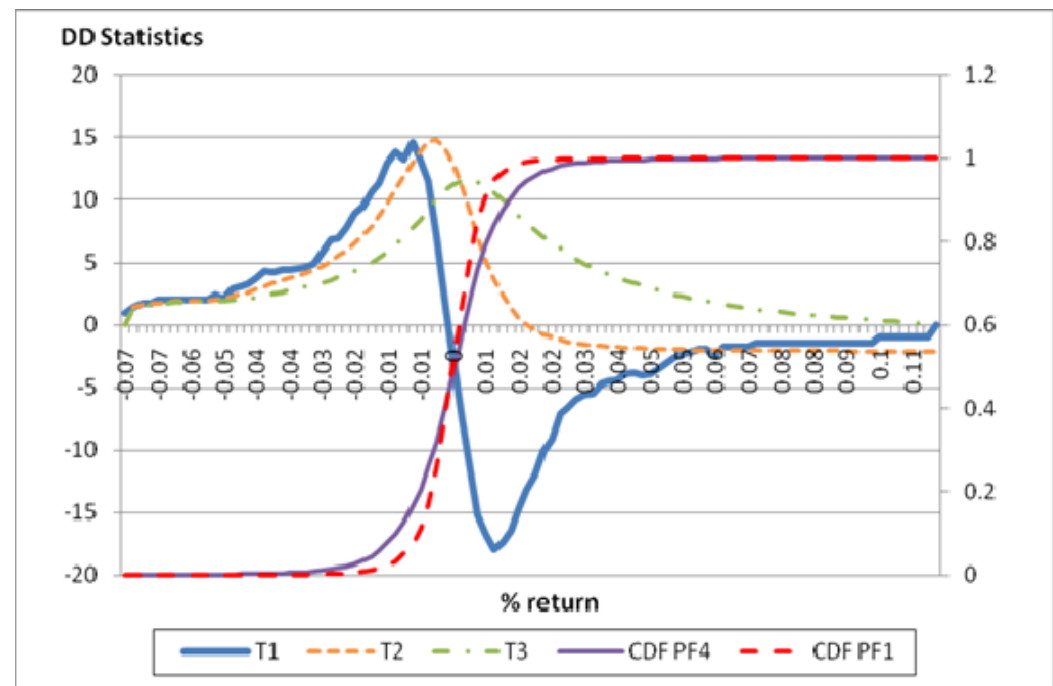
Figure 2. Plot of the cumulative distribution function (CDF) of the daily returns of the fourth domestic diversified portfolio (DOD 4) and the first international diversified portfolio (IND 1) and their DD statistics.